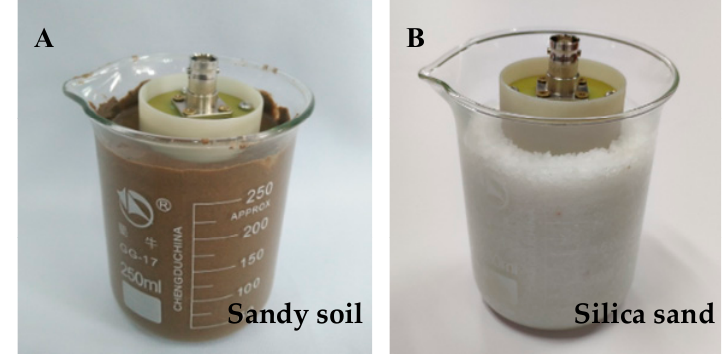
Figure 7. Sandy soil and silica sand.